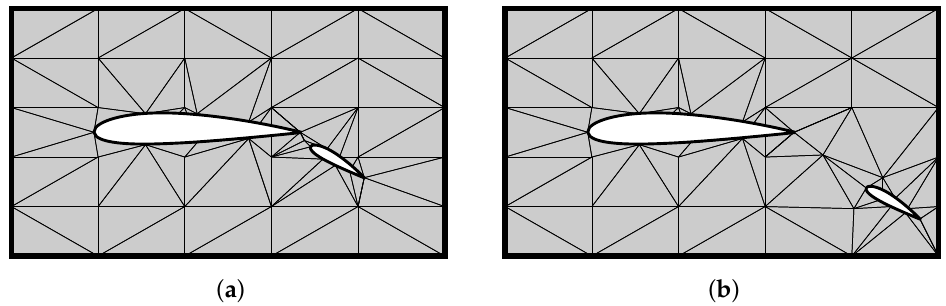
Figure 2. Schematic mesh deformation of airfoil and flap use case. ( a ) Small distance between airfoil and flap. ( b ) Large distance between airfoil and different parameters p f . The cells between the stationary airfoil and the morphed flap are 83 significantly stretched and a good resolution of the flow characteristics in this region is 84 impaired.